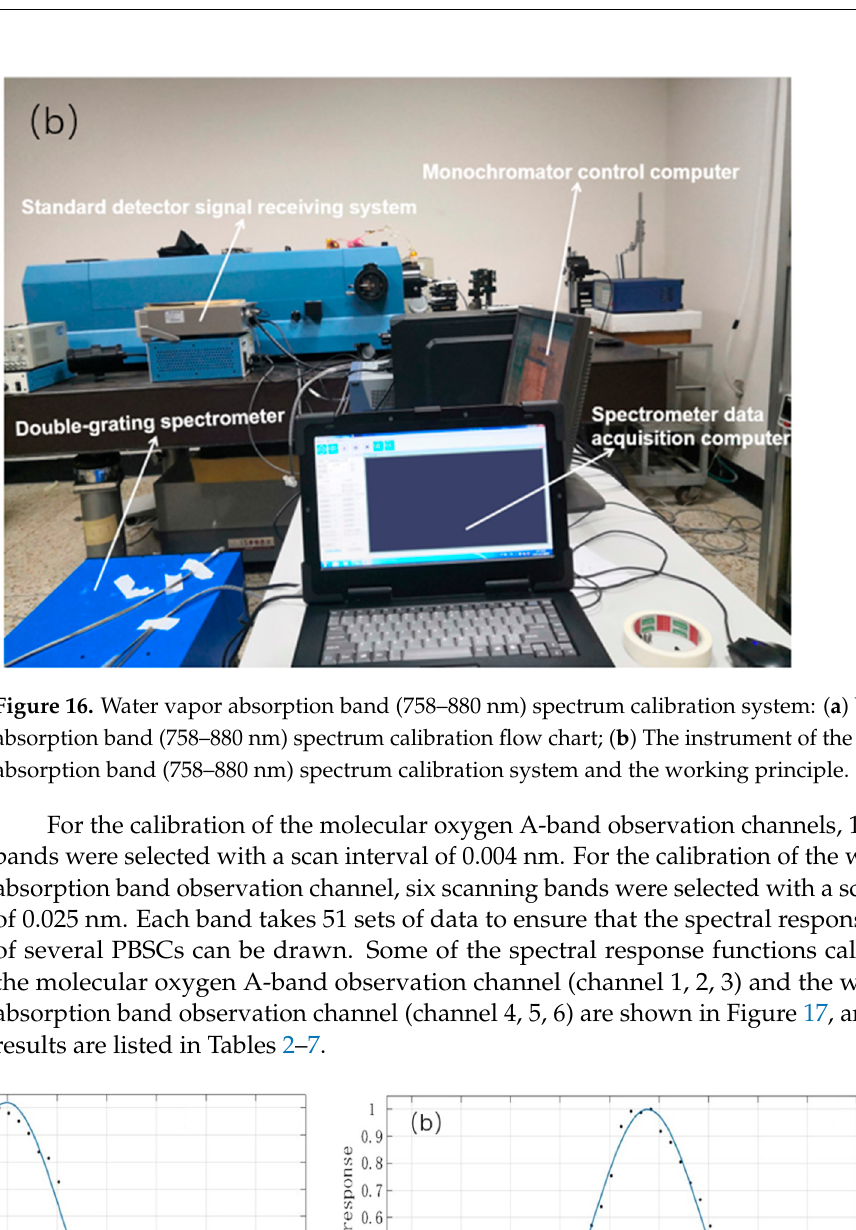
Figure 16. Water vapor absorption band (758–880 nm) spectrum calibration system: ( a ) Water va ‐ por absorption band (758–880 nm) spectrum calibration flow chart; ( b ) The instrument of the water